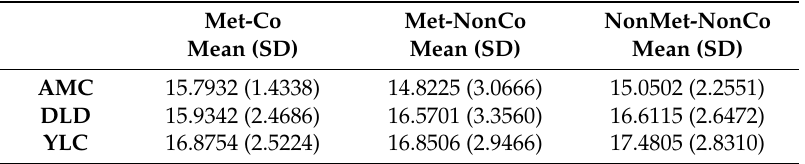
Table 4. Reaction Times (s) by Condition and